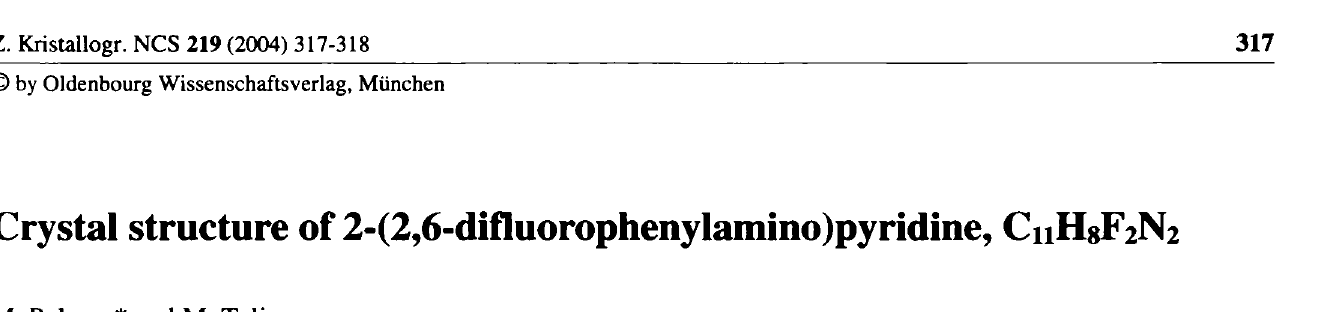
Table 1. Data collection and handling.